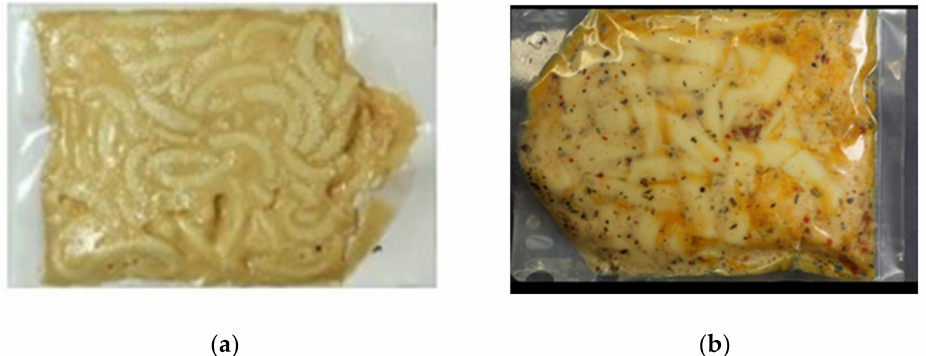
Figure 4. MATS-processed recipes in high-barrier polymeric pouches that could be stored for 3 years or more at room temperature conditions. These recipes in high-barrier packaging may be suitable for U.S. Army rations and NASA extended duration space missions (Reprinted/adapted with permission from Patel et al. [39,56]. ( a ) Mac and cheese in metal oxide-coated multilayer pouches (AlOx PET 12 µ m/OPA 15 µ m/CPP 70 µ m); ( b ) Chicken pasta in metal oxide-coated multilayer pouches (AlOx PET 12 µ m/AlOx PET 12/OPA 15 µ m/CPP 70 µ